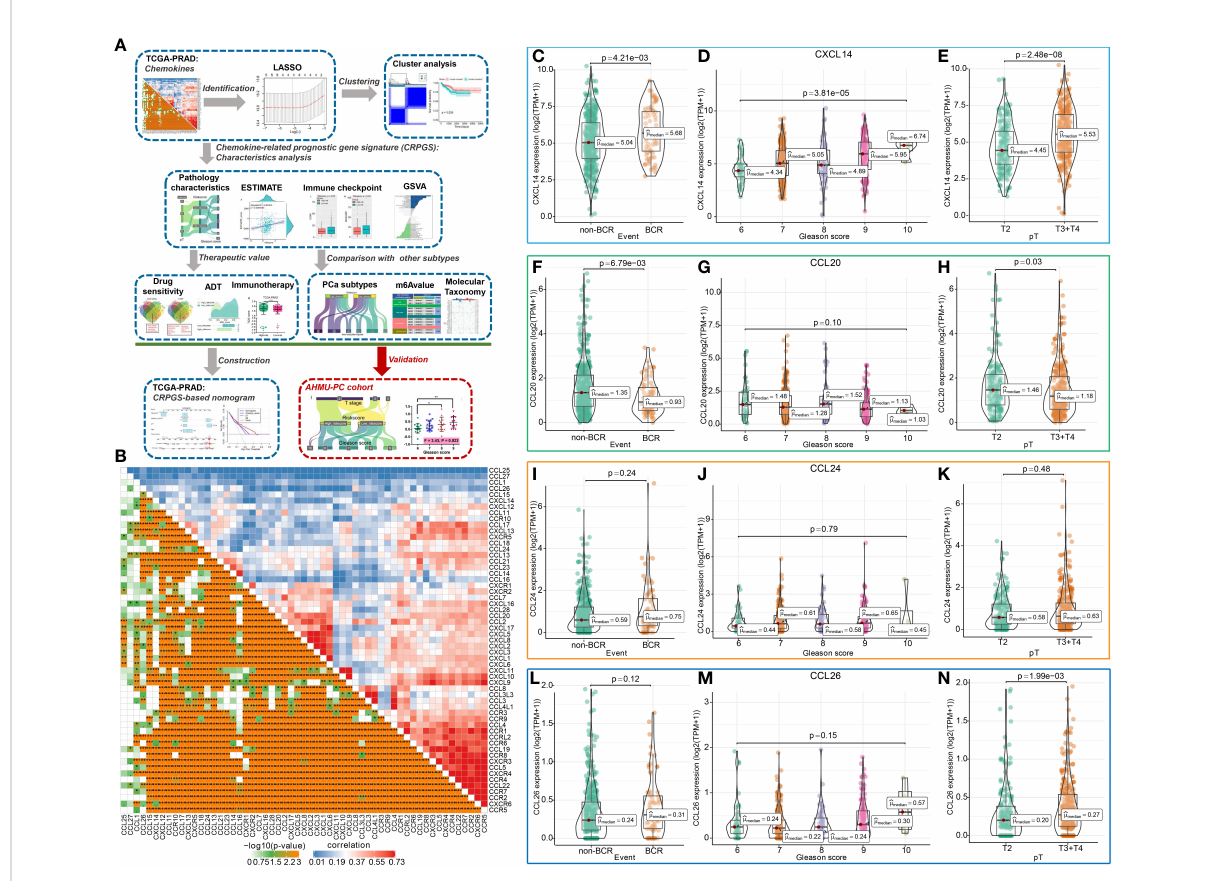
FIGURE 1 The chemokine-related prognostic genes in PCa. The whole process was shown in the fl owchart (A) . The association among 57chemokine genes in PCa (B) , and the distribution of CXCL14, CCL20, CCL24, and CCL26 expression levels in PCa patients with different BCR statuses, Gleason scores, and pathology T stages (C – N)